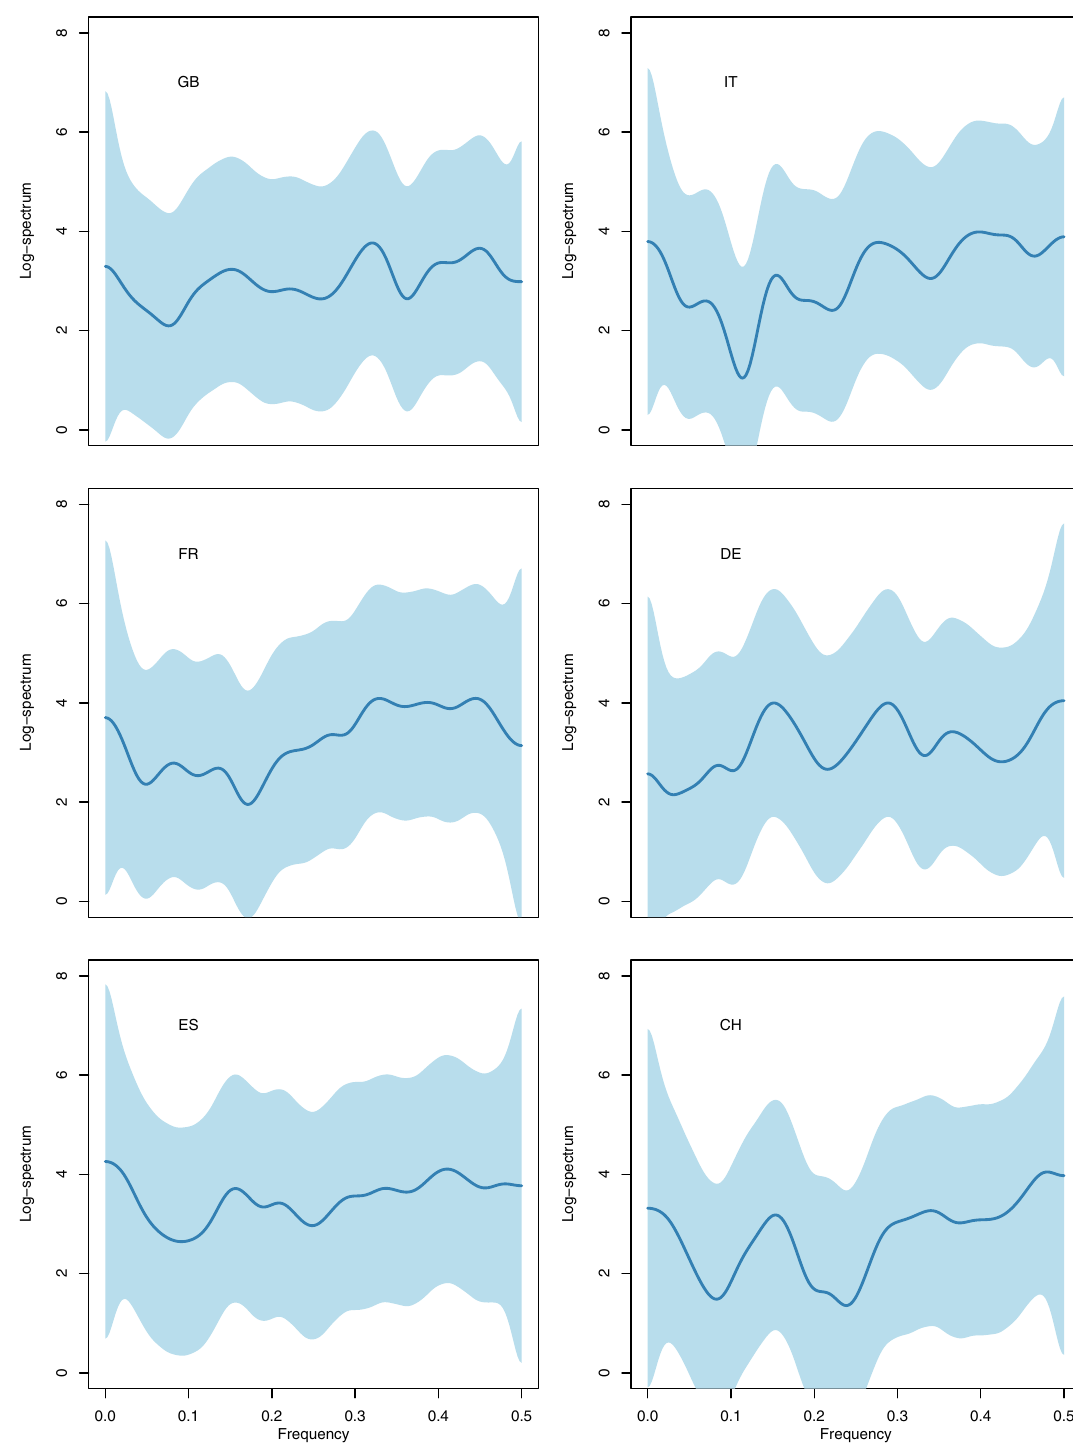
Figure 7. Regspec spectral estimates for numbers of new daily COVID-19 cases. Top-to-bottom, left-to-right: United Kingdom on 52 days, Italy on 54 days, France on 49 days, Germany on 49 days, Spain on 49 days, Switzerland on 47